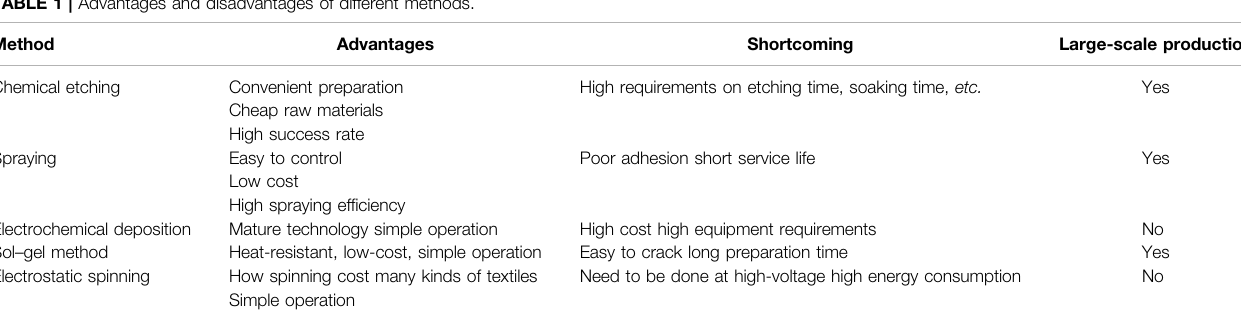
TABLE 1 | Advantages and disadvantages of different